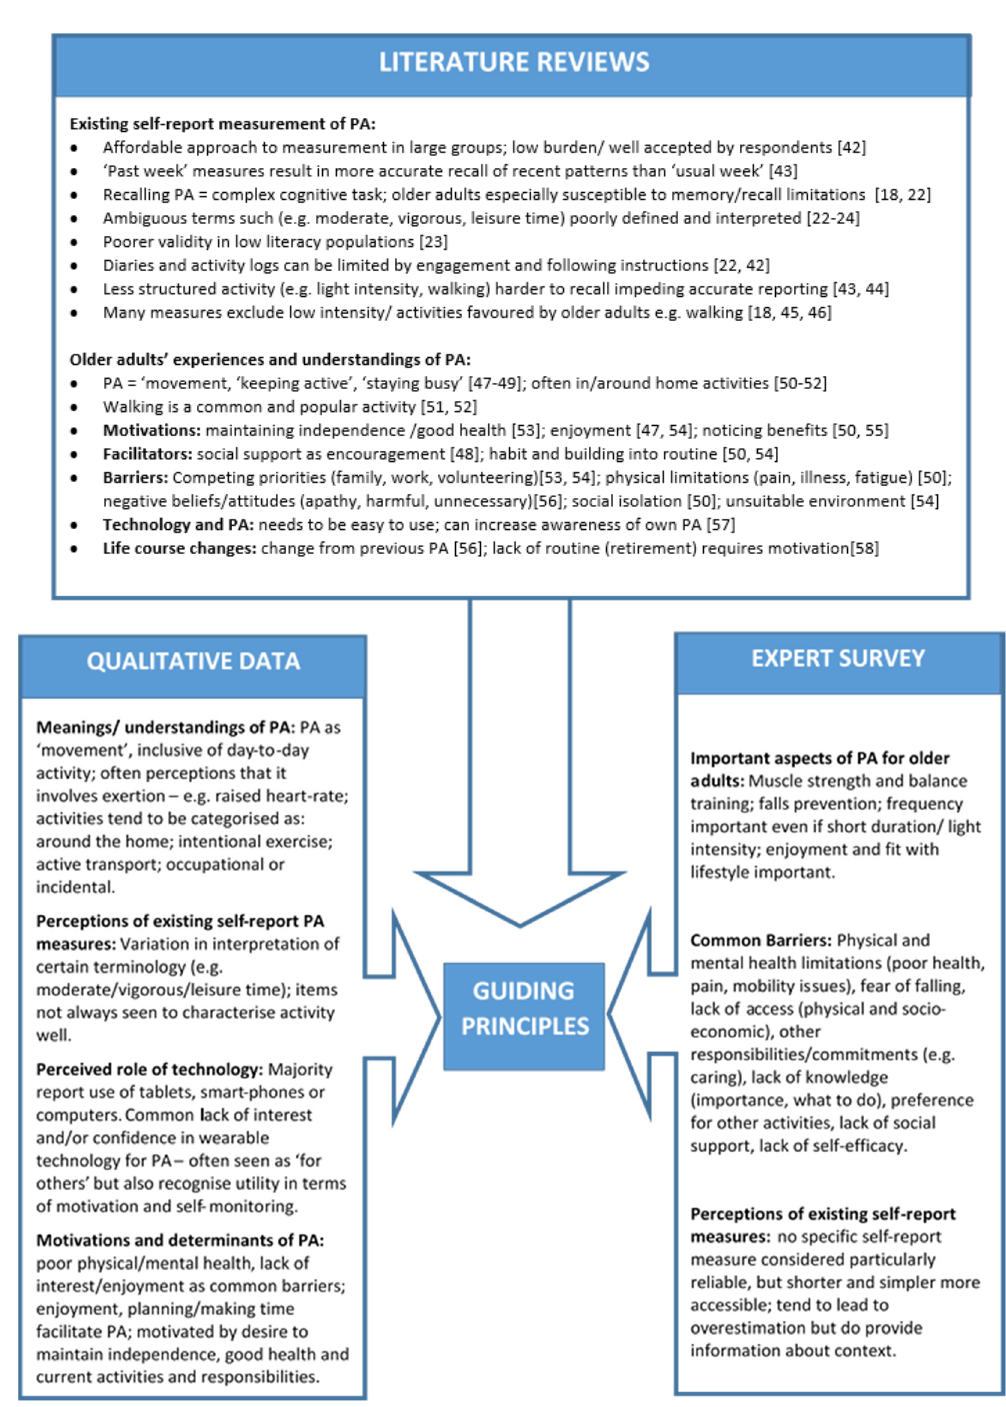
Figure 2. Key findings from planning phase.